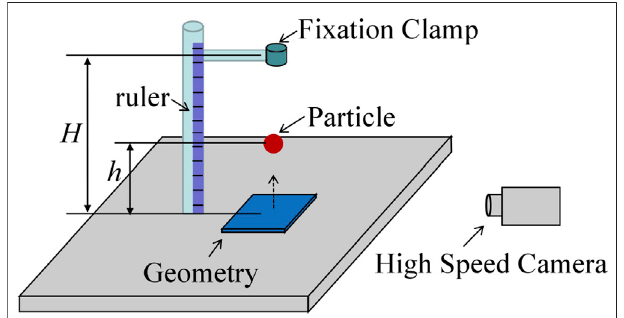
FIGURE 1 | Test device for restitution coef fi